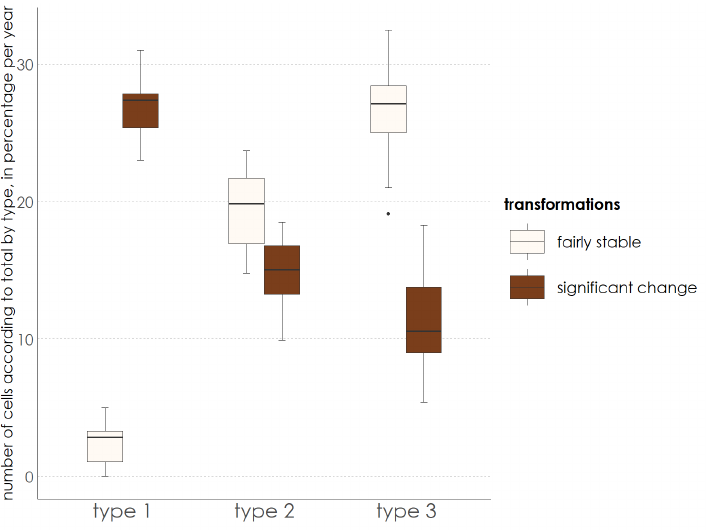
Figure 8. Number of cells corresponding to each type, as a percentage of the annual